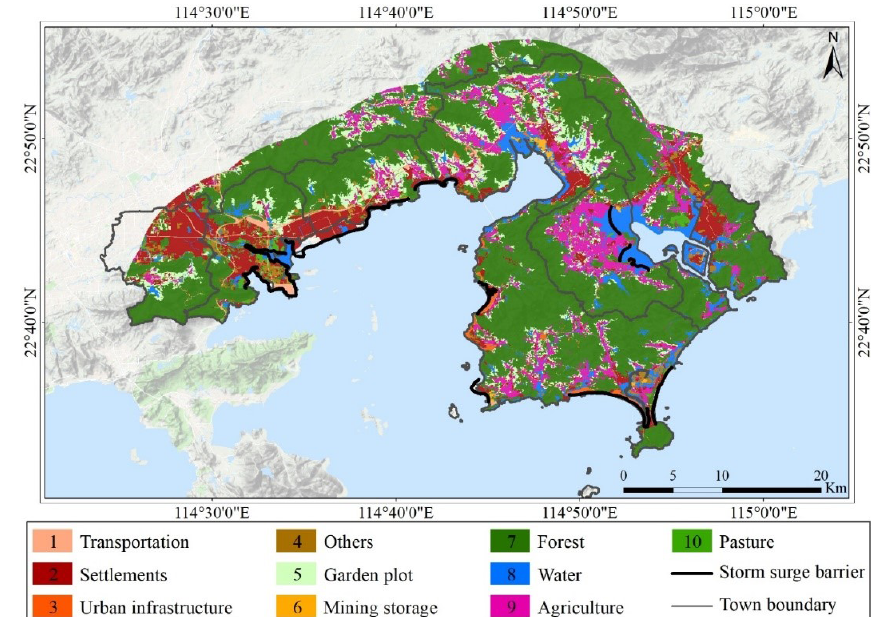
Figure 16. The exposure map of different land cover types in the study area. The map was made using the ArcGIS 10.5 software based on the terrain base map layer, which was obtained from © Google Maps (map data © 2019